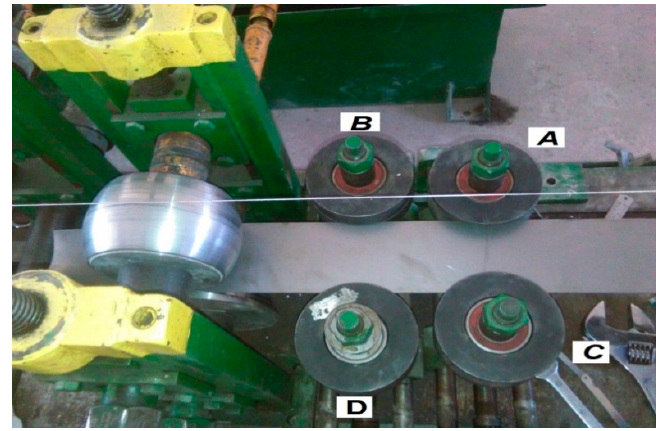
Figure 10. Strip-guiding systems at the forming line beginning.